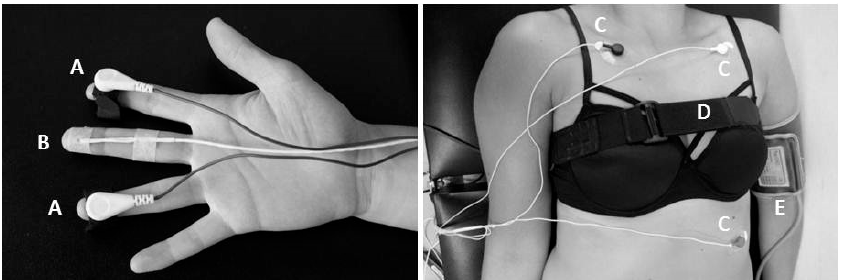
Figure 2. Electrode placement. Legends: A: skin conductance sensors, B: skin temperature sensor, C: ECG electrodes standard lead II placement, D: elastic belt with piezoelectric sensor to measure respiration rate, E: inflatable cuff placement of the electronic blood pressure